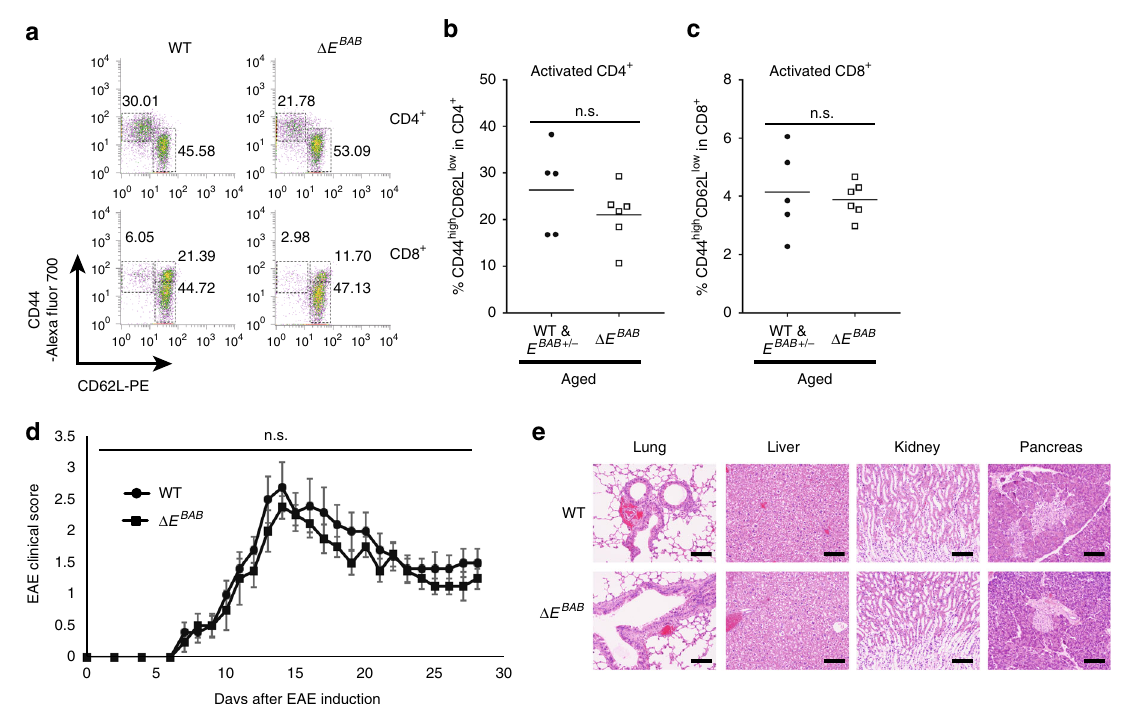
Fig. 8 Δ E BAB mice do not show any autoimmune phenotype. a Flow cytometric analysis of CD62L versus CD44 populations in CD4 + or CD8 + splenic T cell. The number in the plot is representative percentage of each gate. For CD4 + T cells, gates indicate activated (CD44 high CD62L low ) and naïve (CD44 low CD62L high ) populations. For CD8 + T cells, activated effector memory (CD44 high CD62L low ), activated central memory (CD44 high CD62L high ) and naïve (CD44 low CD62L high ) populations are gated. Data are representative of four independent experiments ( n = 5 for WT and E BAB + / − mice, n = 6 for Δ E BAB mice from WT & E BAB + / − – Δ E BAB littermate pairs and trios, 30 – 34 weeks old). b , c Activated CD4 + ( b ) and CD8 + ( c ) proportions of aged mice. Data are pooled from four independent experiments ( n = 5 for WT and E BAB + / − mice, n = 6 for Δ E BAB mice from WT and E BAB + / − – Δ E BAB littermate pairs and trios, 30 – 34 weeks old). d The mean (±s.e.m.) clinical scores at the days after EAE was induced in WT (control) ( n = 10) and Δ E BAB mice ( n = 8). The incidence of EAE: control 10/10, Δ E BAB 8/8. No data point showed statistically signi fi cant difference between WT and Δ E BAB (i.e., unpaired